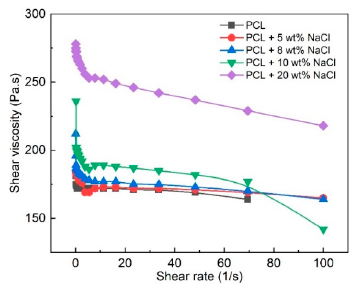
ff erent NaCl additive